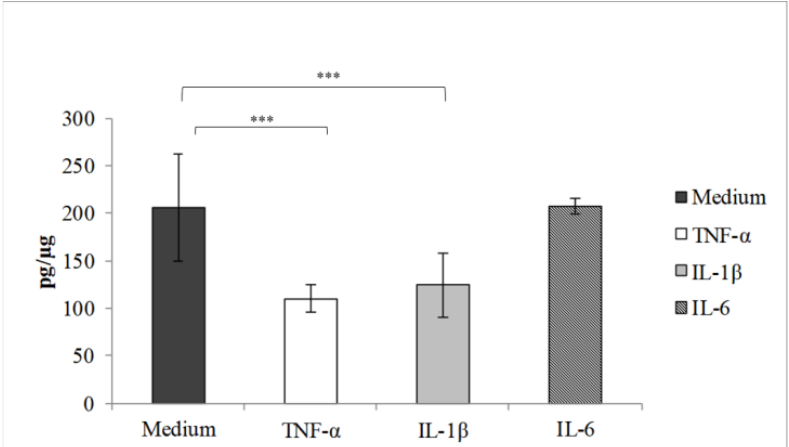
Figure 5. Intracellular accumulation of digoxin in VK2/E6E7 cells stimulated with cytokines. The accumulation of digoxin in VK2/E6E7 cells post-cytokine stimulation is shown in comparison to the unstimulated control. The data is presented as digoxin accumulated (pg/µg) ± SD ( n = 6). Statistical analysis was a one-way ANOVA using Bonferroni correction, *** p < 0.001.